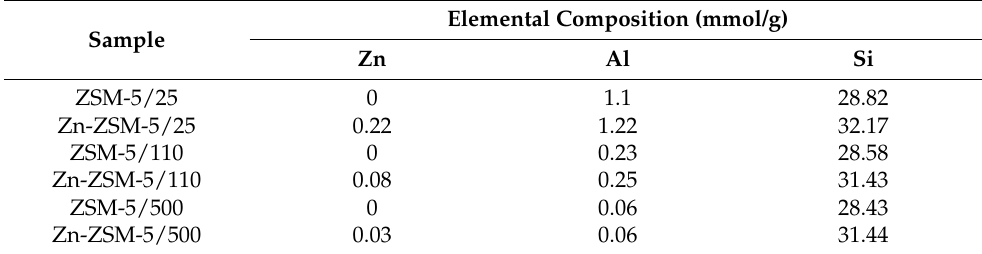
Table 2. Elemental composition of samples measured by